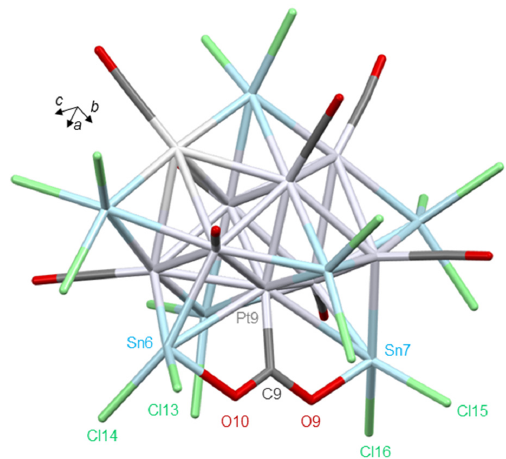
Figure 27. Molecular structure of 28 , adapted from [81] (MERCURY view). Hydrogen atoms, two and a half molecules of acetone and four tetra- n -butylammonium cations are omitted for clarity (Sn light blue, O red, Cl light green, Pt light grey, C grey).